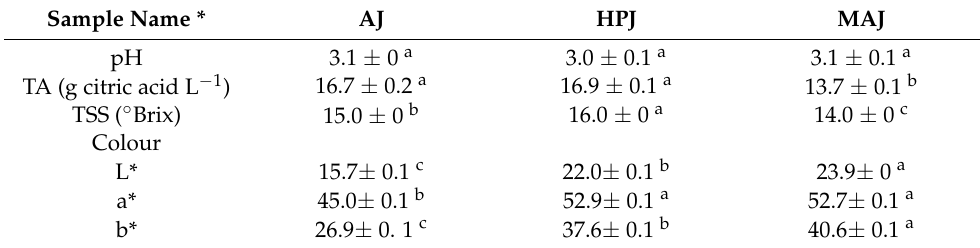
Table 1. Standard chemical analysis of the pomegranate juice